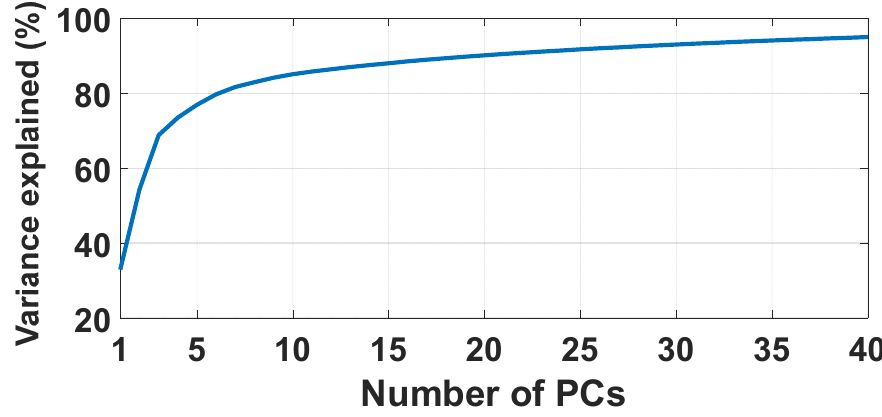
Figure 5. Cumulative variance explained as a function of the number of PCs.